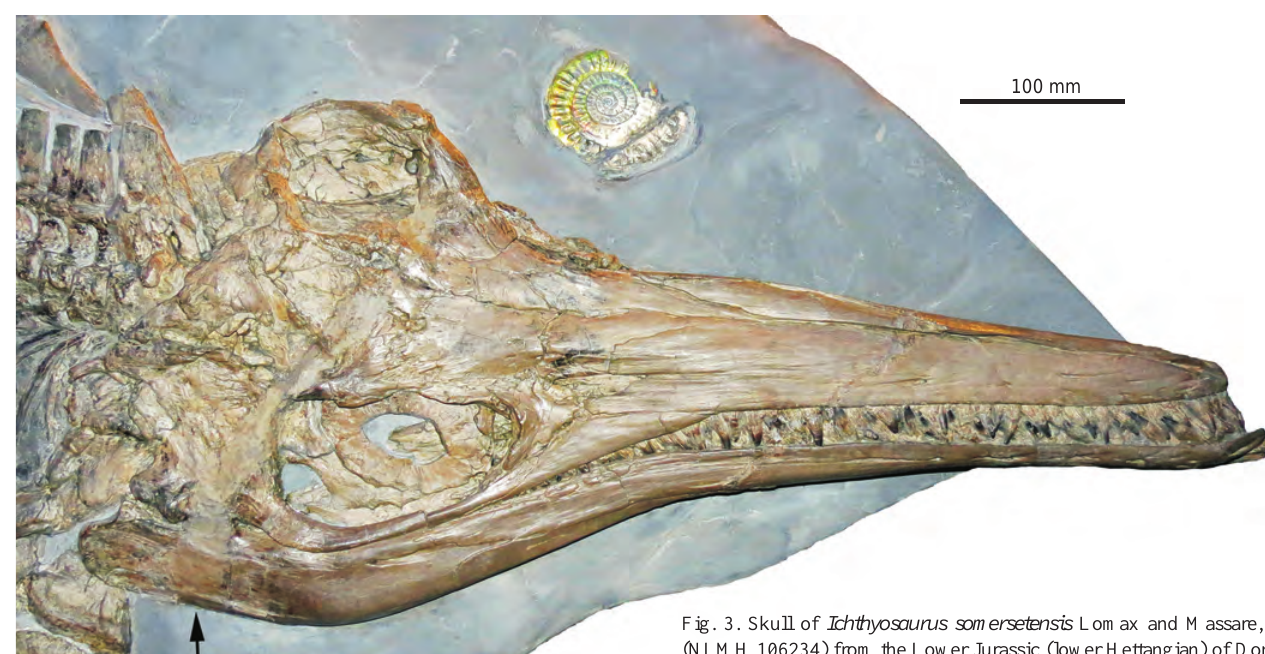
Fig. 3. Skull of Ichthyosaurus somersetensis Lomax and Massare, 2017 (NLMH 106234) from the Lower Jurassic (lower Hettangian) of Doniford Bay, Watchet, Somerset, UK; in dorsolateral view. Arrow points to the re- construction that extends across the